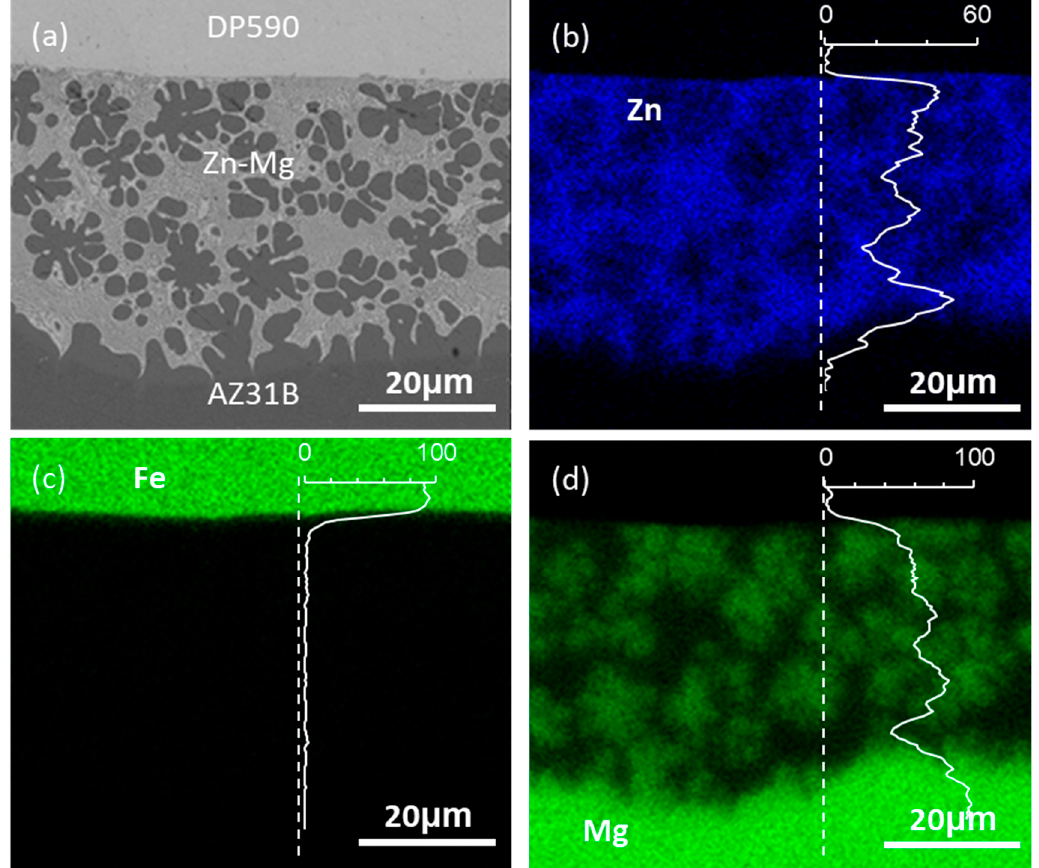
Figure 7. Morphology and chemical composition at the center of the joint interface on welds produced with high welding energy (Experimental Setup 2 condition as listed in Table 1). ( a ) SEM image of the bonding interface between DP590 and AZ31B, and the element maps in the same region: ( b ) Zn, ( c ) Fe and ( d ) Mg. The inserted line plots represent the quantification of each composition along the dashed line. The unit of the horizontal axis is in count.